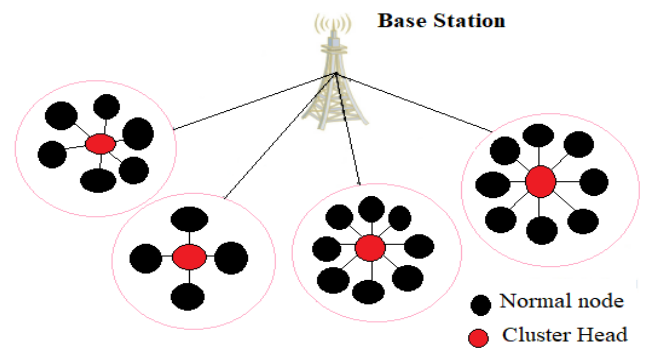
Figure 3. LEACH Clustering Structure.